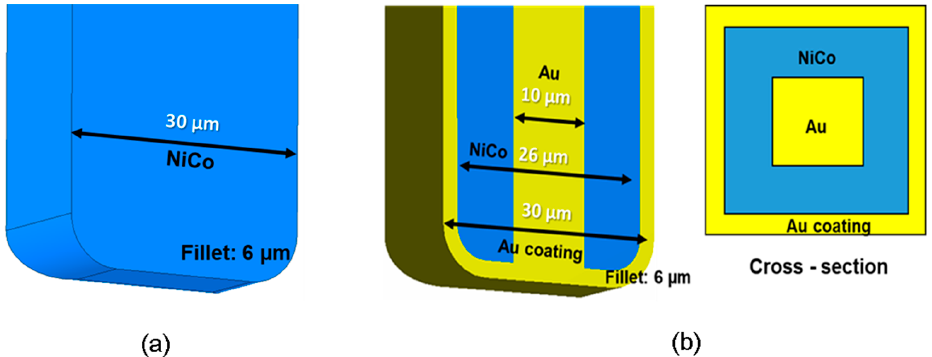
Table 1. Properties of materials used in analyses of the current-carrying capacities.